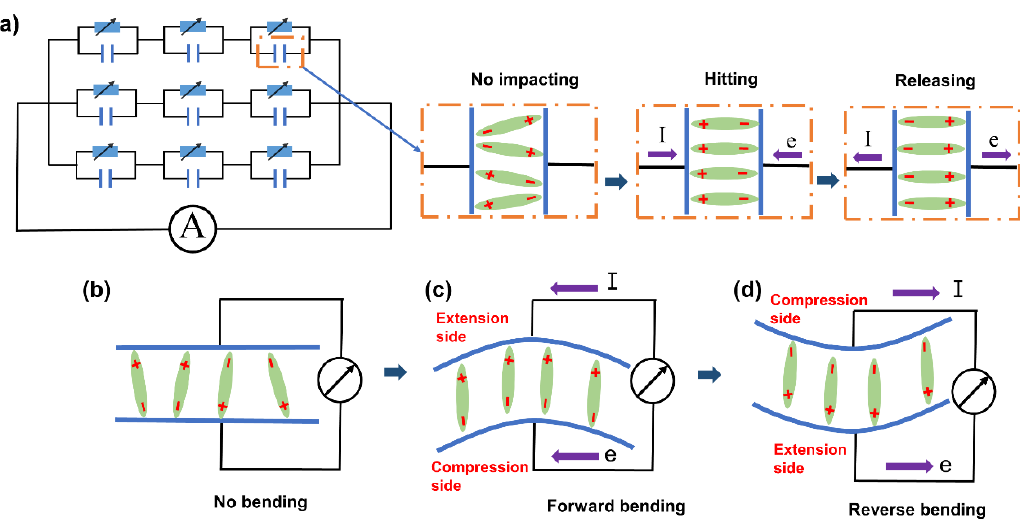
Figure 5. ( a ) Schematic diagram of the sensor being subjected to applied pressure and released pressure. ( b ) Unbent state. ( c ) Forward bending state. ( d ) Reverse bending state.